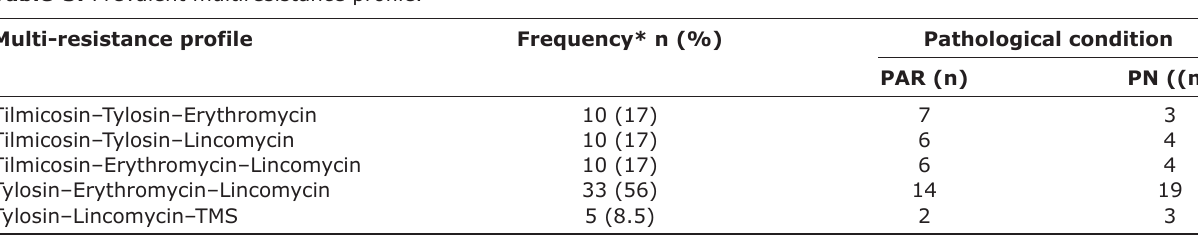
Table-3: Prevalent multiresistance profile. Multi-resistance